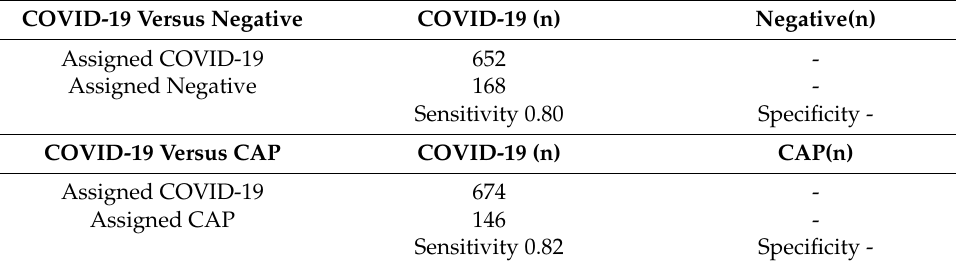
Table 4. Independent testing II performance of the proposed AI system.